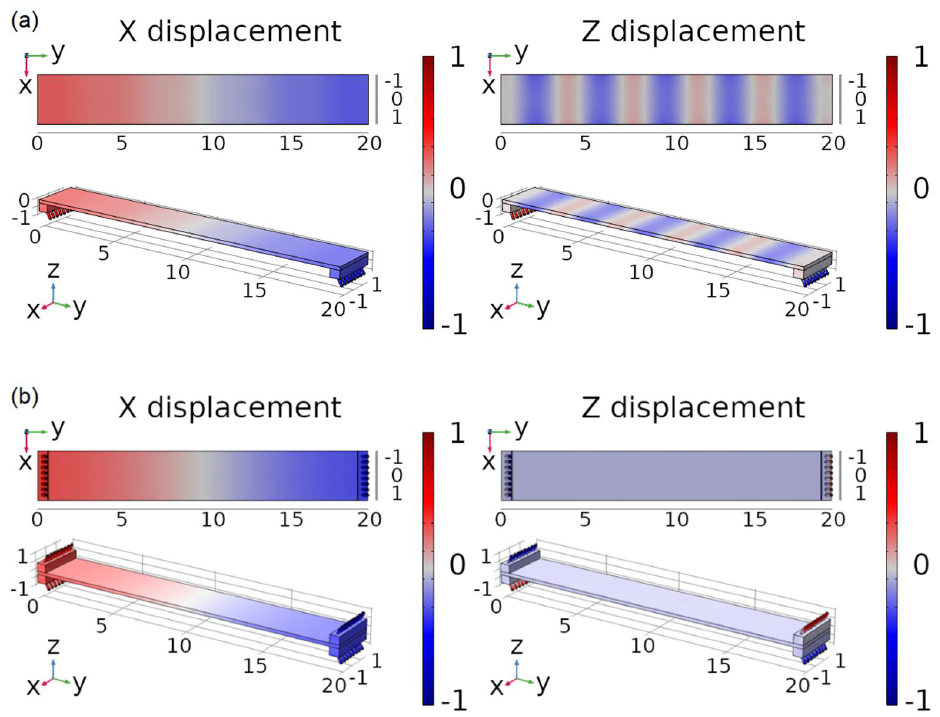
Figure 3. Top view and 3D view of the in-plane and out-of-plane normalized displacements of the first extensional mode of the PZT plate with ( a ) legs attached at the bottom and ( b ) legs attached at both the top and the bottom of the plate.